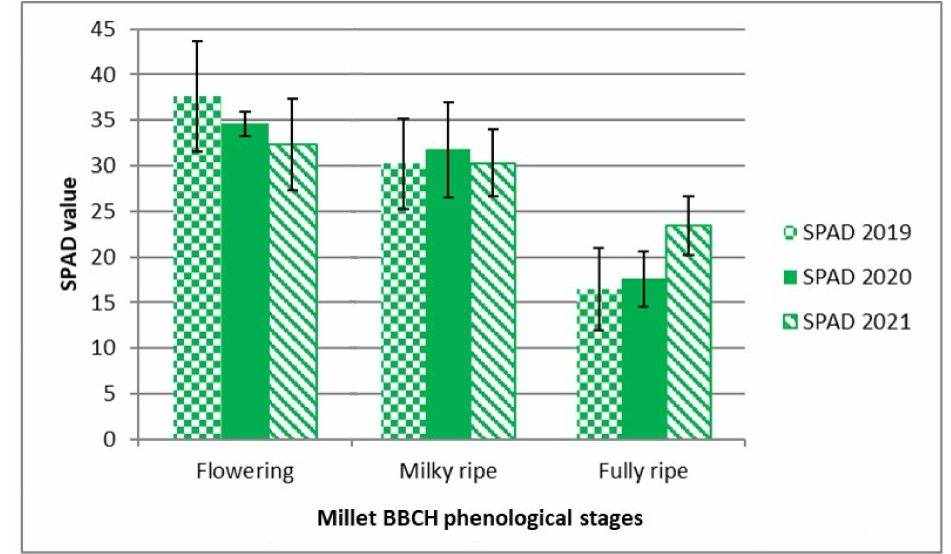
Figure 6. SPAD values at the same phenological stages at the VM site in 2019, 2020, and 2021. Bars indicate the standard